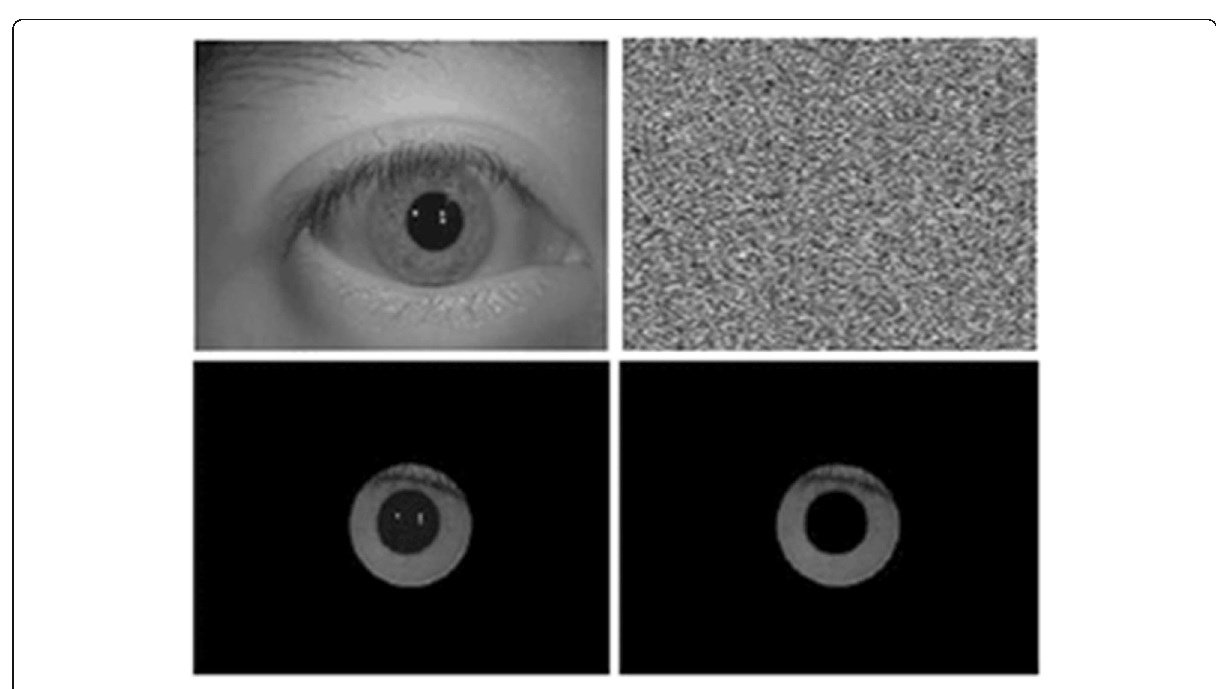
Fig. 4 Encryption of iris image